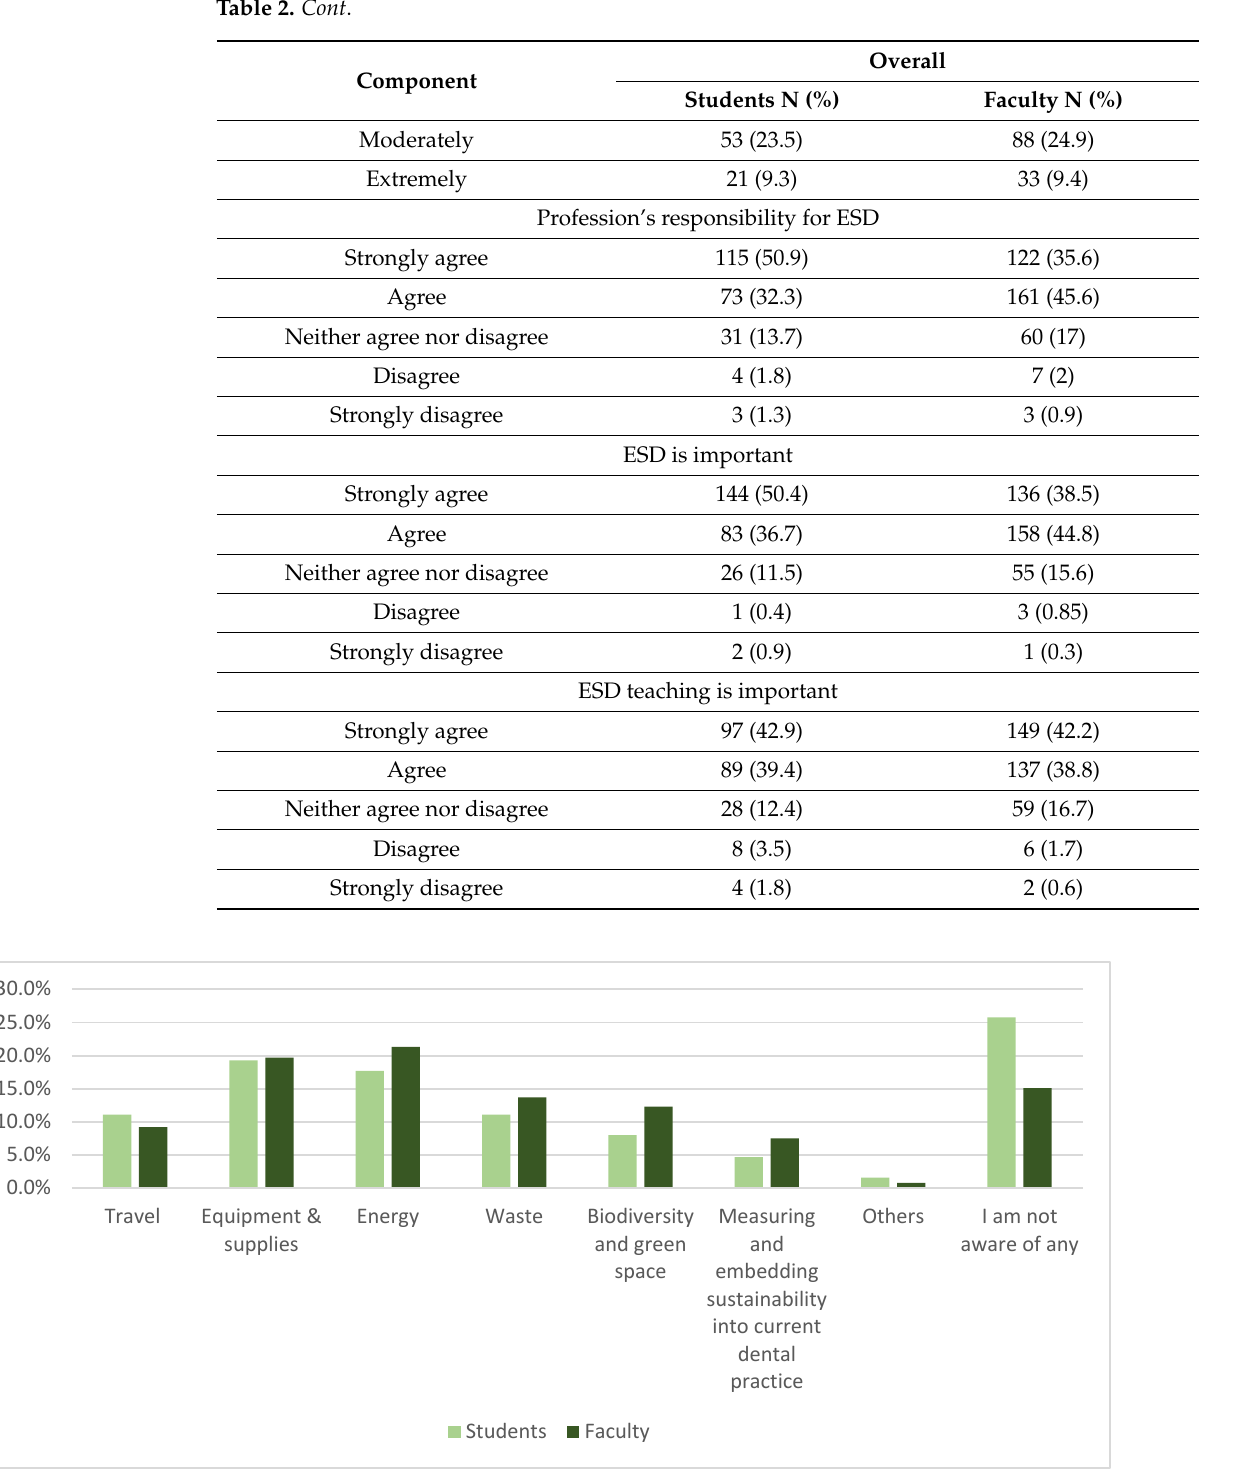
Figure 1. This bar chart demonstrates the awareness of existing policies, protocols, initiatives, or events concerning environmentally sustainable dentistry (ESD) by students and faculty members.